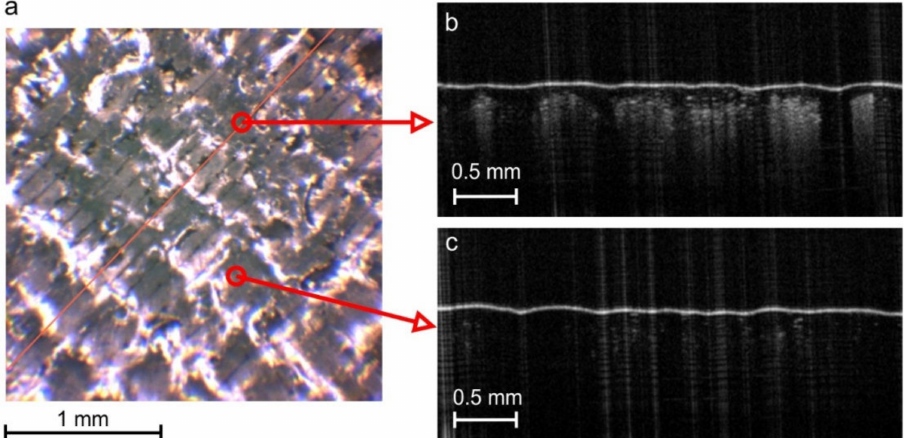
Figure 15. Surface view of the metallic layer formed on a flexible composite substrate after profile measurements using the contact method: ( a ) camera image with visible parallel furrows formed during the measurement; ( b ) OCT cross-section of the place where the profilometer measuring needle passed; ( c ) OCT cross-section between the measuring needle movement